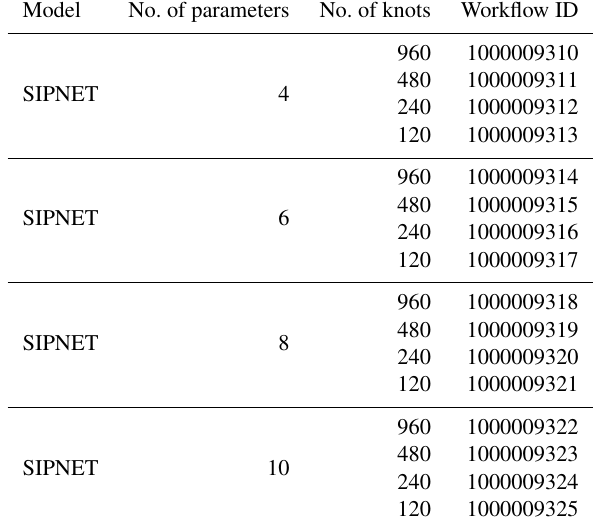
Table A8. Links to the workflow IDs of scaling experi- ments. Parameters targeted are in this order